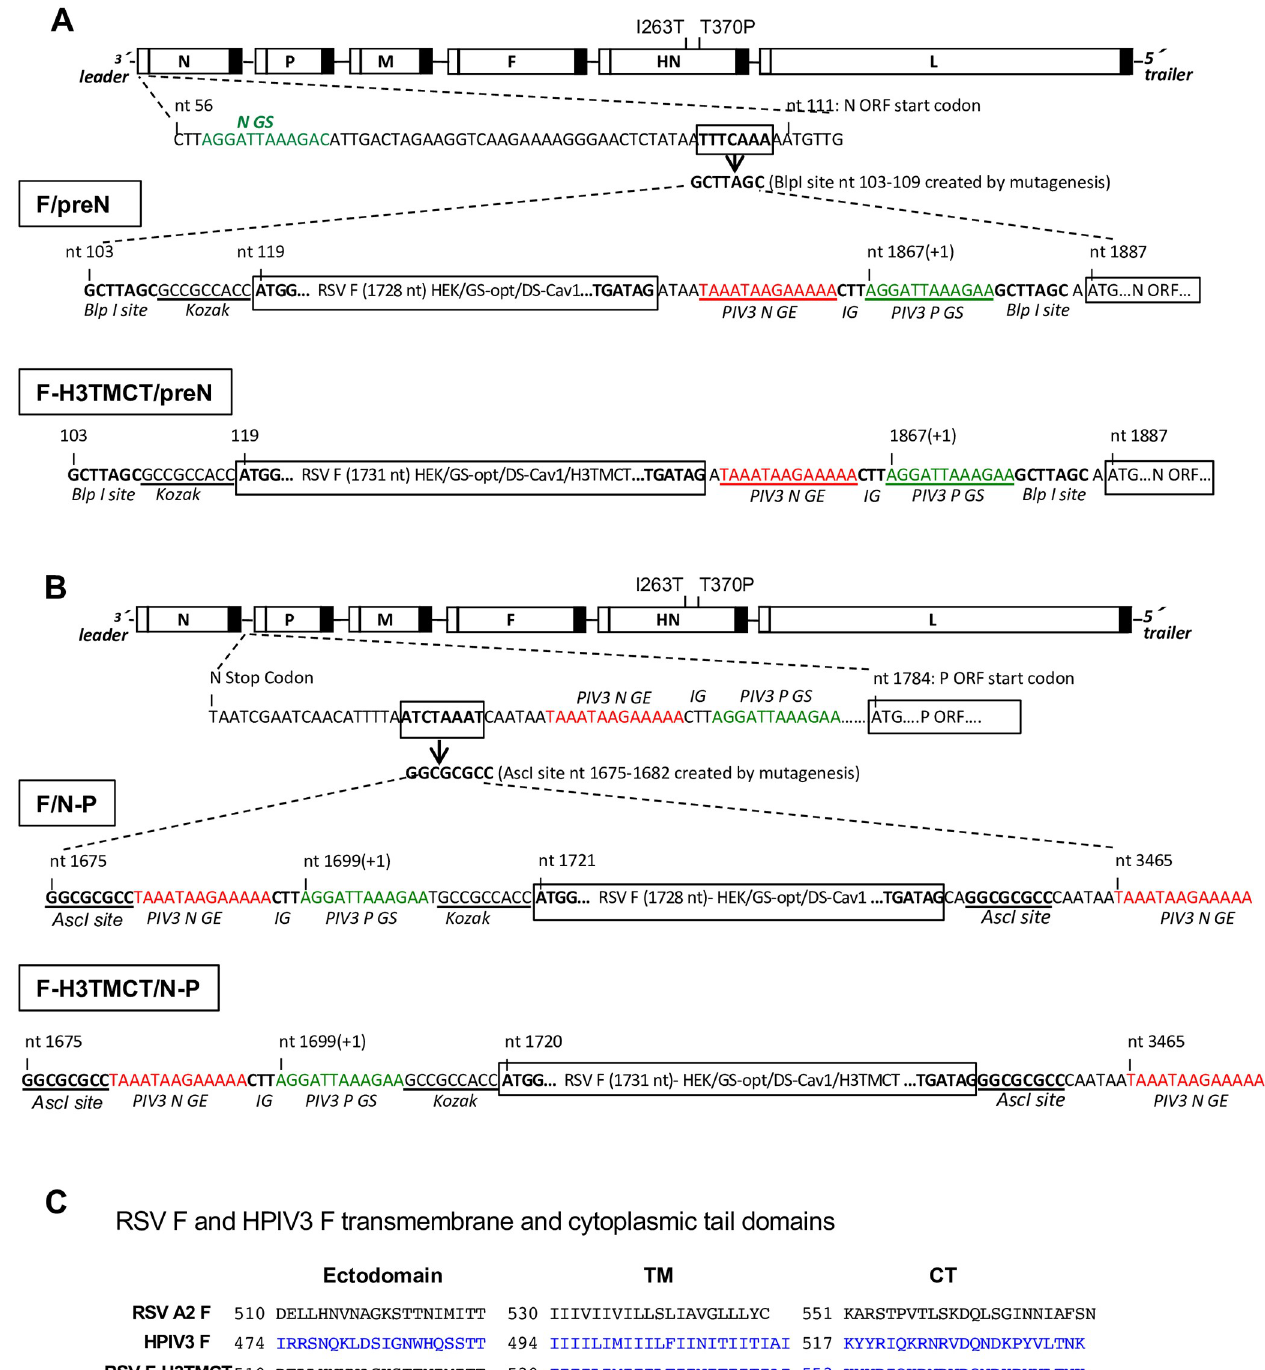
Fig 1. Genome structures of the rHPIV3-RSV-F vectors. The codon-optimized RSV F ORF containing the HEK and DS-Cav1 mutations (see Results) was engineered to contain an optimal translational start site (underlined and labeled “Kozak” [36]) and was flanked by HPIV3 gene-end (GE) and gene-start (GS) transcription signals and the intergenic CTT trinucleotide to allow for expression as a separate mRNA. RSV F was either the full-length protein (constructs F/ preN and F/N-P) or a chimeric version in which the transmembrane (TM) and cytoplasmic tail (CT) domains of RSV F were replaced by those of the HPIV3 F protein (constructs F-H3TMCT/preN and F-H3TMCT/N-P). The insert was placed (A) at the first gene position using the Blp I site or (B) the second gene position using the Asc I site in the wild type (wt) rHPIV3 JS strain vector. The vector contained I263T and T370P amino acid substitutions that restore the wt sequence (see the text). (C) Nucleotide sequences of the TM and CT domains and part of the adjoining ectodomains of RSV strain A2 F protein (top), HPIV3 F protein (middle), and chimeric RSV-F-H3TMCT protein.